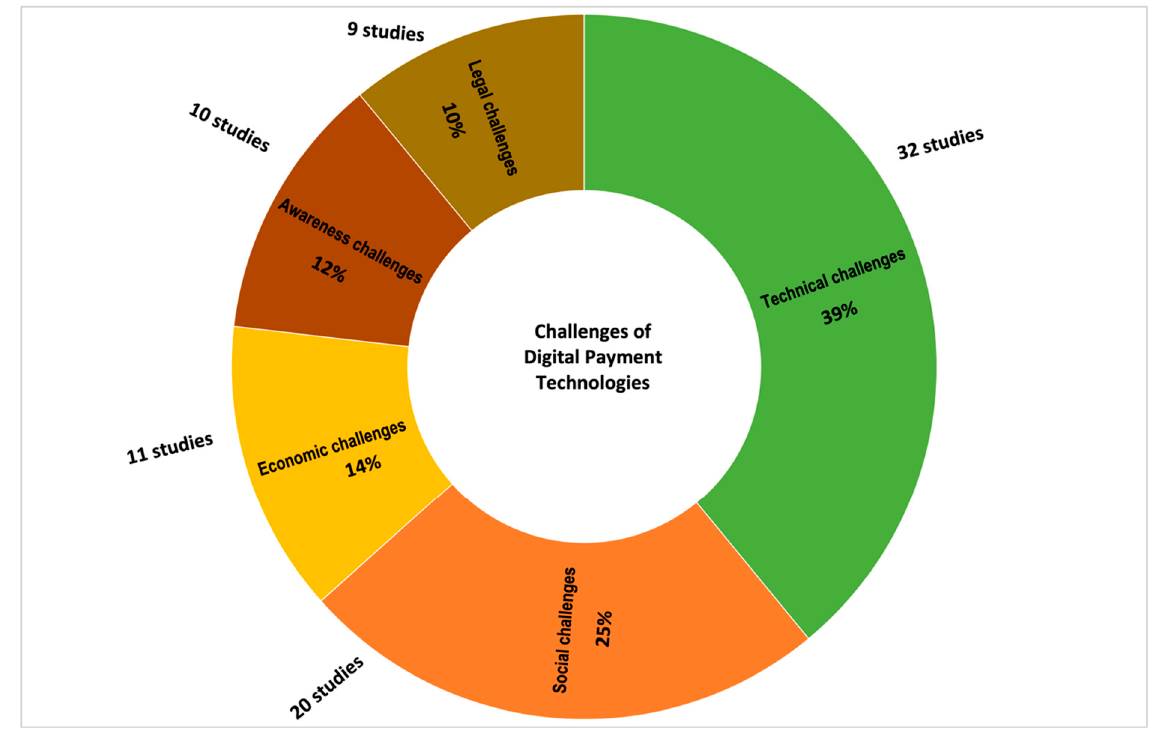
Figure 5. Categorization of digital payment technology challenges.